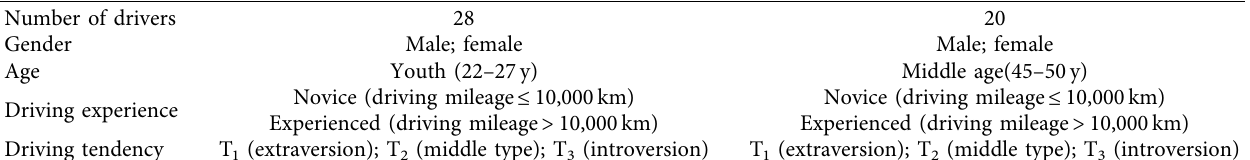
Table 1: Statistics of drivers’ information.